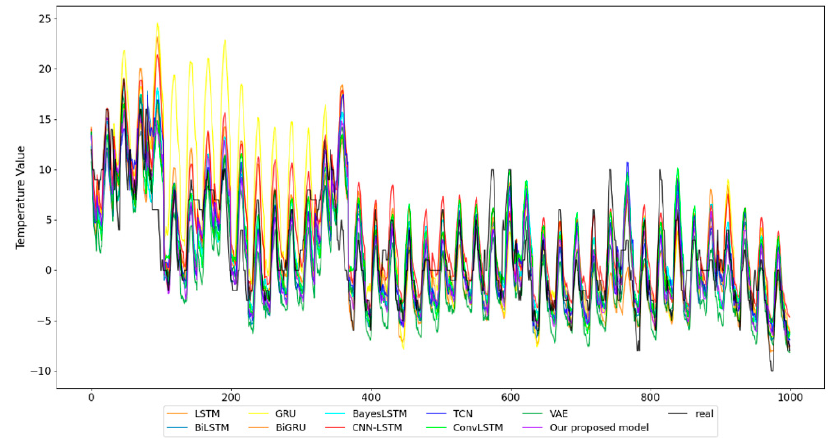
Figure 7. Plots of prediction results of different models on temperature datasets.